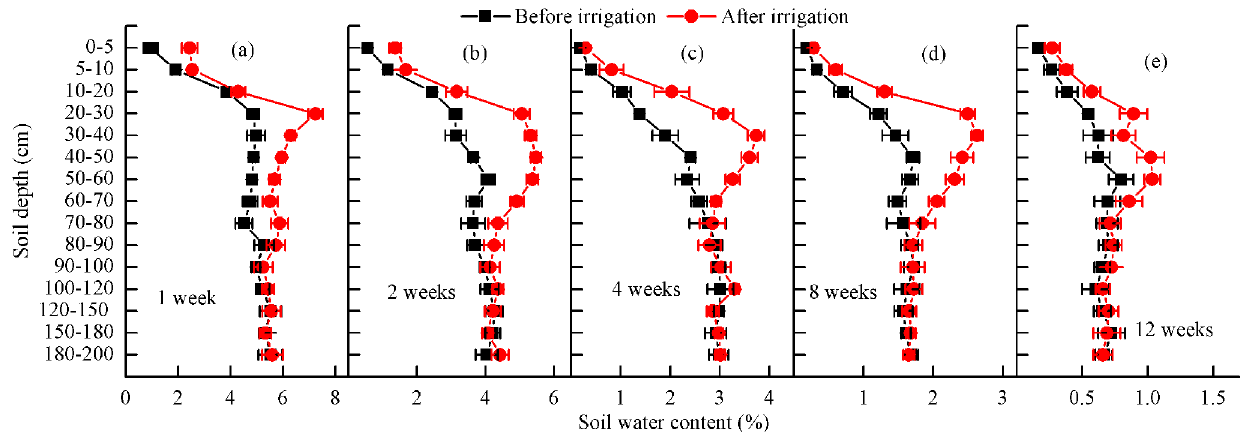
Fig 2. Vertical distribution of soil water content before and after the irrigation intervals of 1 (a), 2 (b), 4 (c), 8 (d) and 12 (e) weeks.